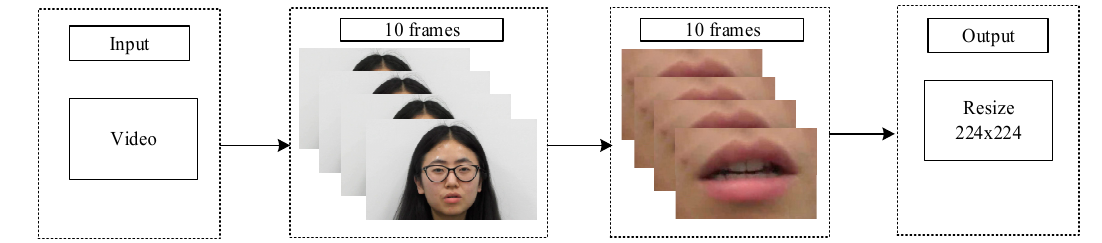
Figure 2. Preprocessing steps with example frames.